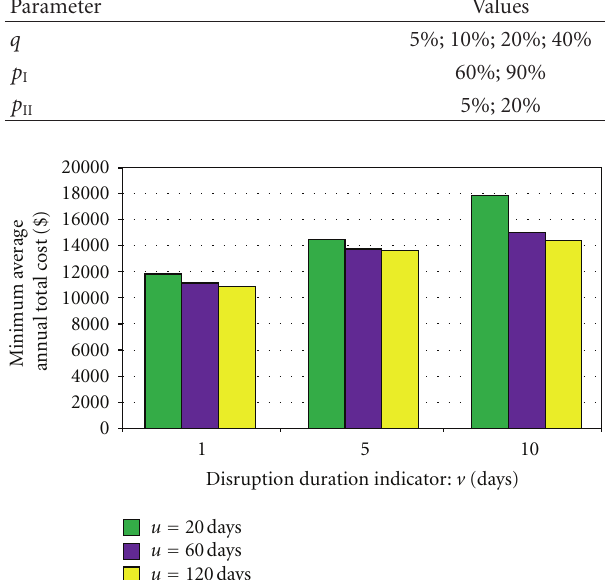
Figure 6: The impact of u on ATC under di ff erent scenarios of v .